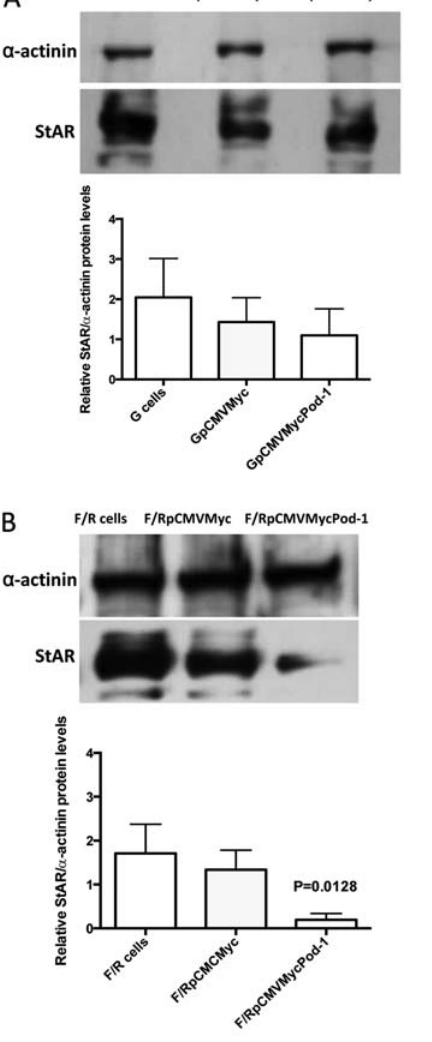
Figure 7. Immunoblotting analysis of relative StAR/ a -actinin protein levels in primary rat adrenal glomerulosa cells (G cells; A ) and fasciculata/reticularis cells (F/R cells; B ) untransfected or transiently transfected with the empty vector pCMVMyc or with pCMVMycPod-1. Protein samples were prepared 72 h post- transfection. Data are reported as the means ± SD from three experiments. Statistical signi fi cance was assessed by paired t -tests between cells transfected with pCMVMycPod-1 or empty vector.